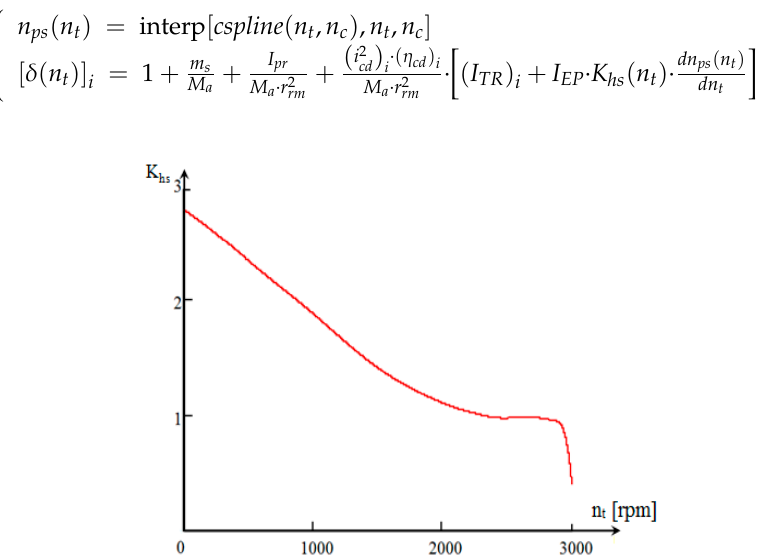
Figure 7. The dependence between the transformation ratio and turbine speed. Sensors 2020 , 20 , x FOR PEER REVIEW